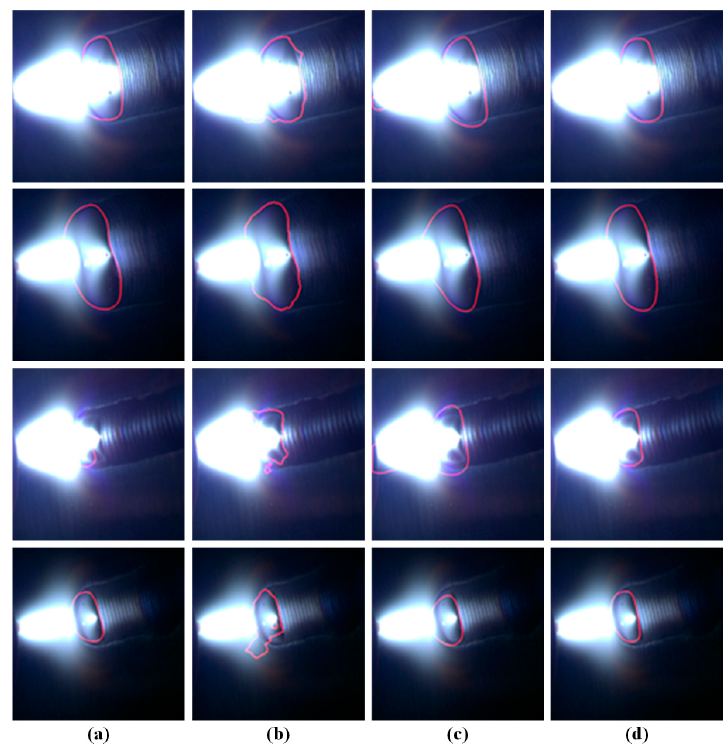
Figure 11. Test result of robustness test data set: ( a ) ResSeg (based on ResNet-101); ( b ) ENet; ( c ) ResSeg